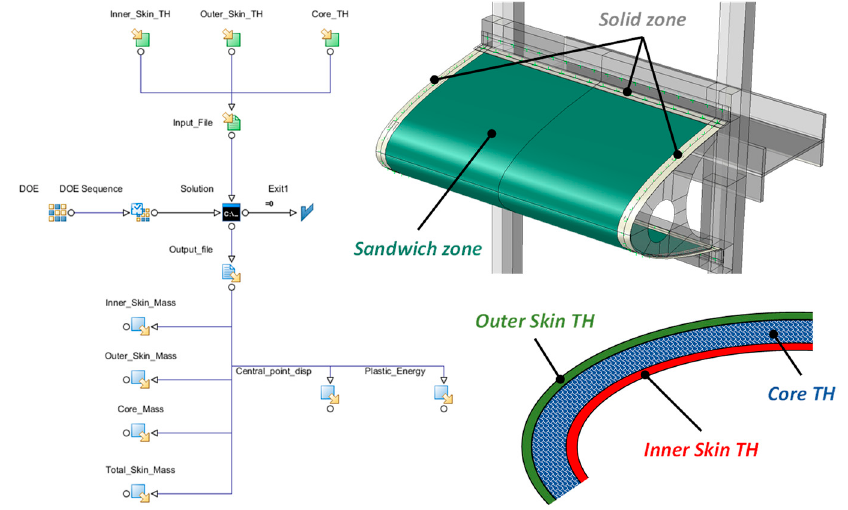
Figure 7. Sensibility analysis workflow and detail of design variables.